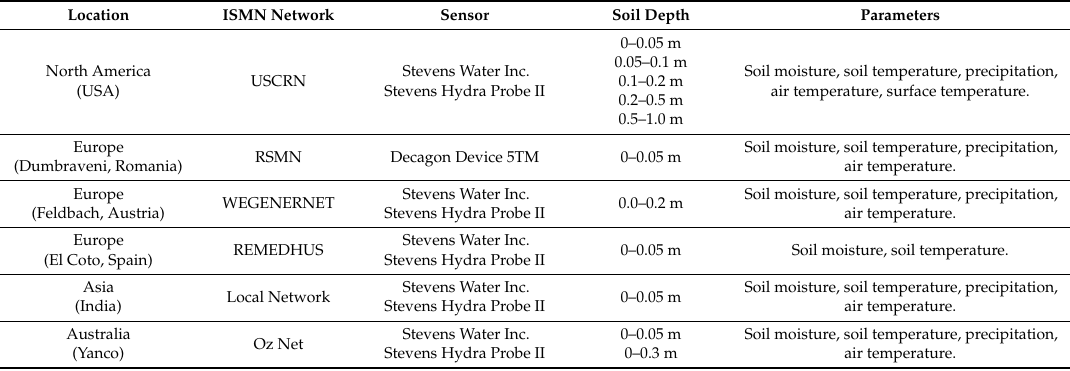
Table 1. Characteristics of the main ground observational networks used in our